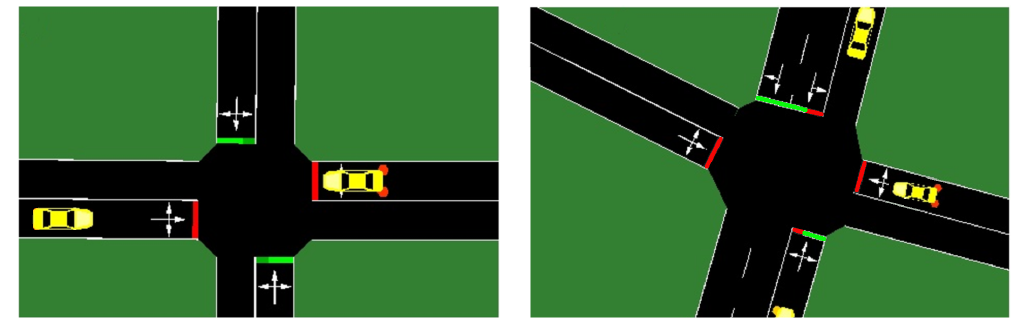
Figure 7. Examples of simulated